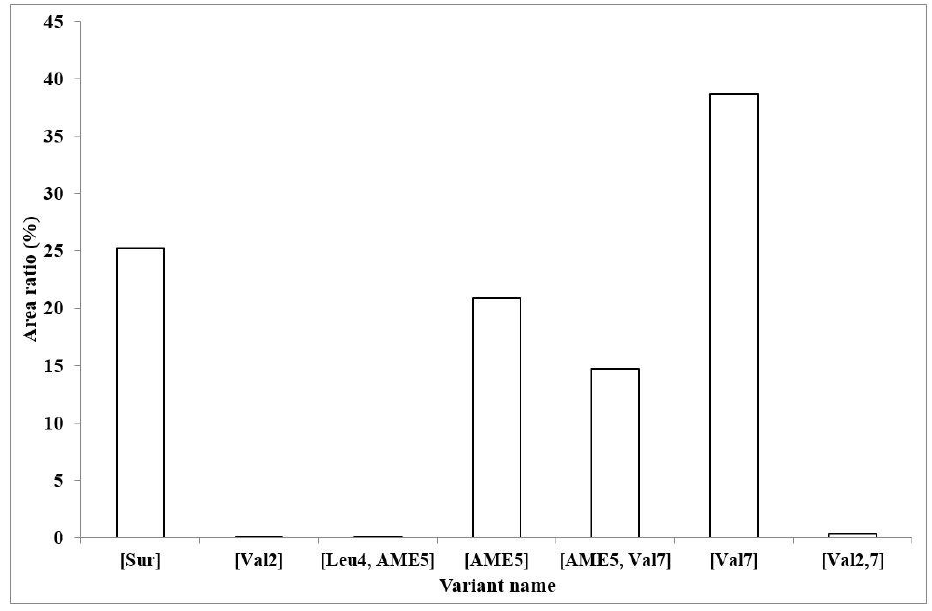
Figure 5. The ratios of all the produced surfactin isoforms in our sample. The percentage values are based on the integrated areas of the particular peaks of each isoform in the extracted ion chromatograms.